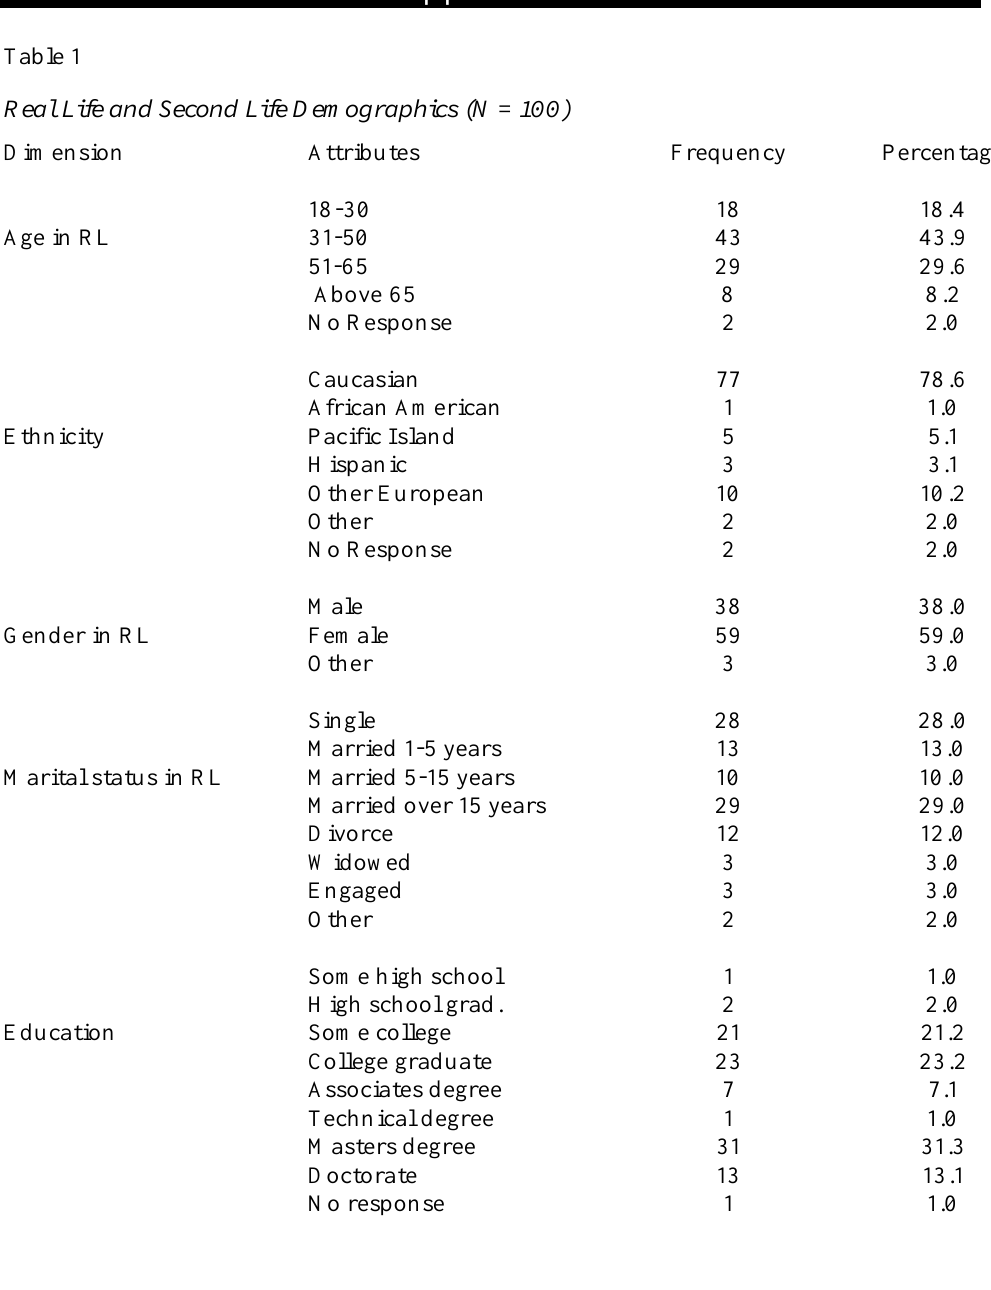
Real Life and Second Life Demographics (N = 100)